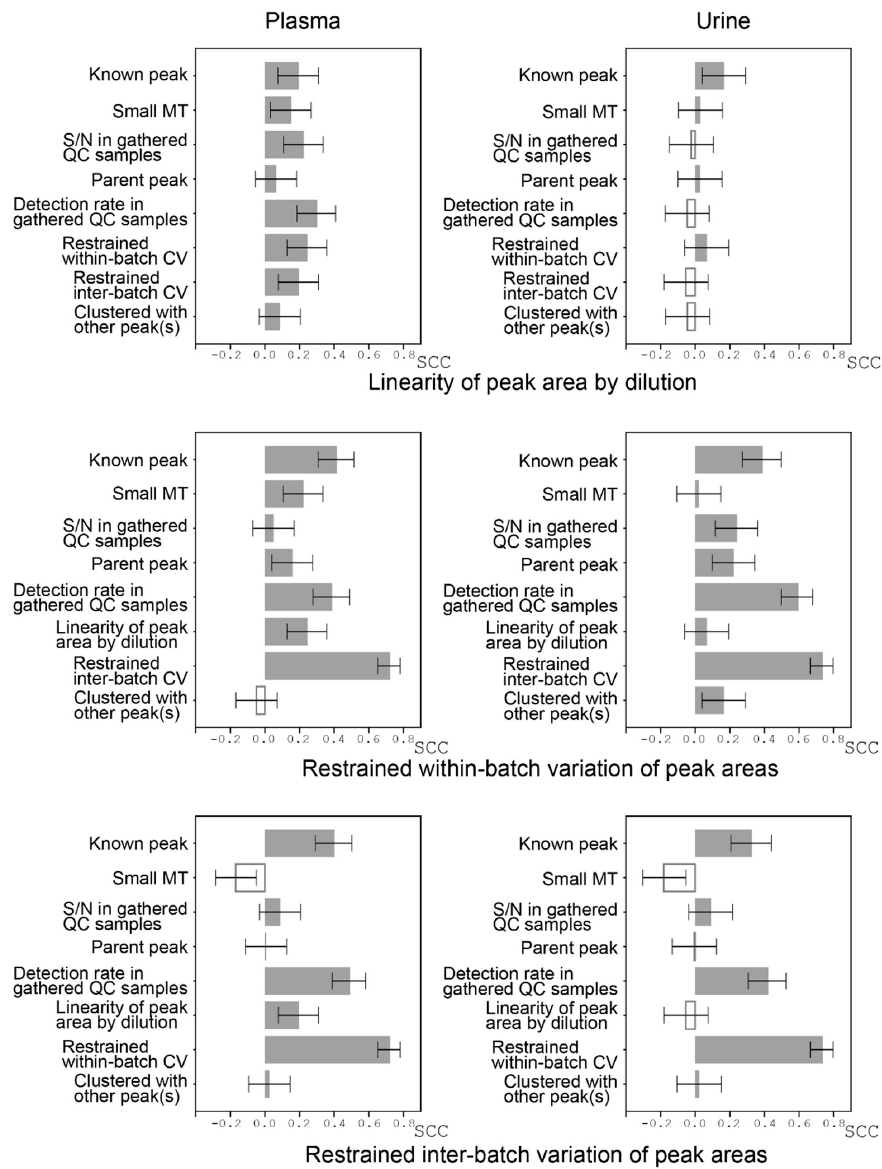
Figure 6. Correlations between factors that may be related to the reliability of the peaks. Spearman’s correlation coefficients (SCCs) between three main reliability factors and other factors were calculated to assess the influence of the other factors on the major factors. The three main reliability factors were linearity of relationship between the amounts of samples (determined by dilution rates) and peak areas (denoted as “Linearity of peak area by dilution”), and how well within-batch and inter-batch variations were restrained. Linearity of peak area by dilution was defined as Pearson’s correlation coefficient between the amounts of samples and the peak areas. The restrained coefficient of variation was defined as − 1 × coefficient of variation (CV). The “Known peak” variable was 1 if the peak is known one; otherwise it was 0. “Small MT” was defined as − 1 × (migration time). The “Parent peak” variable was 1 if its potential isotope or adduct ion was observed; otherwise it was 0. The “Clustered with other peaks” variable was 1 if the peak was clustered with other peaks; otherwise it was 0. The SCCs are shown as bars with 95% confidence intervals. The filled bars indicate positive SCC values.